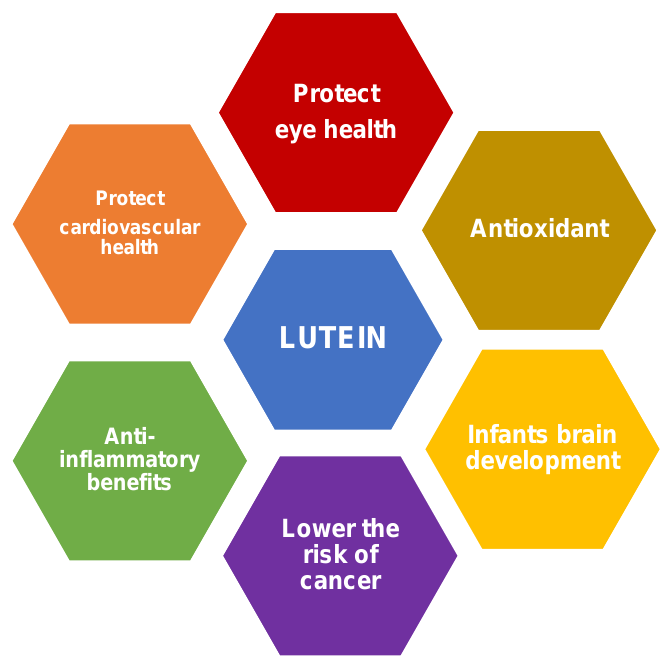
Figure 1. Schematic showing multiple potential health benefits of lutein.